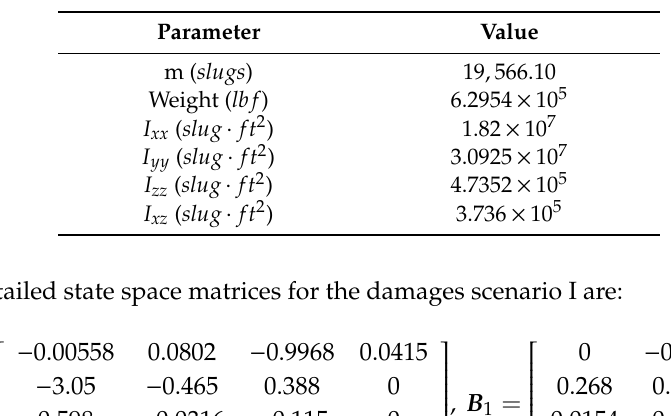
Table 4. Related data for the damaged